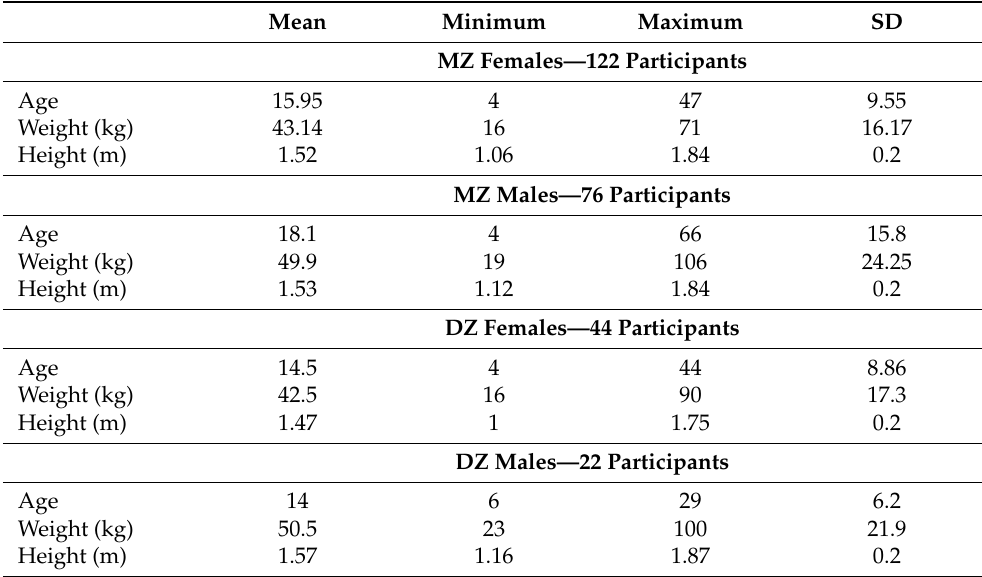
Table 1. Demographic